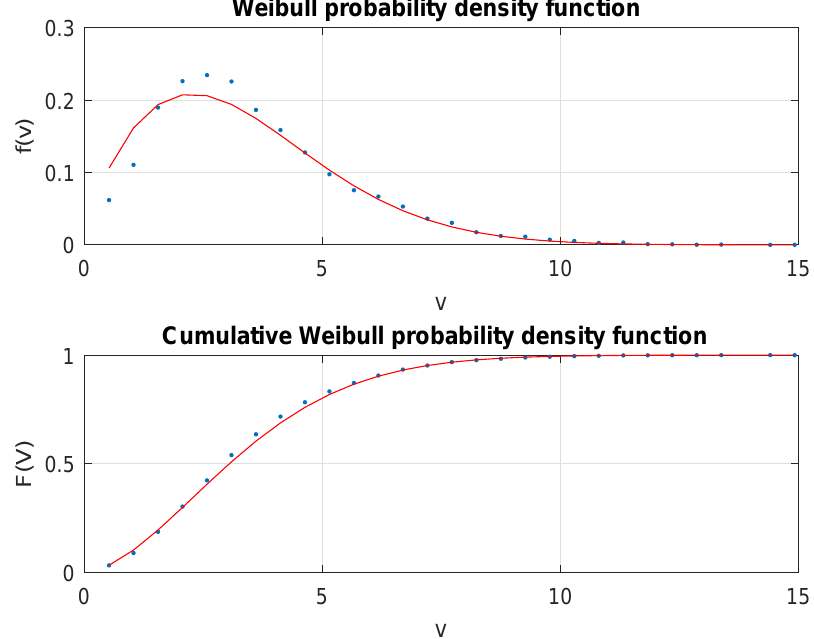
Figure 24. The portraits of Weibull and Cumulative Weibull probability density functions in OSWFs in Yangshan port, Shanghai from 22 August 2017 to 22 August